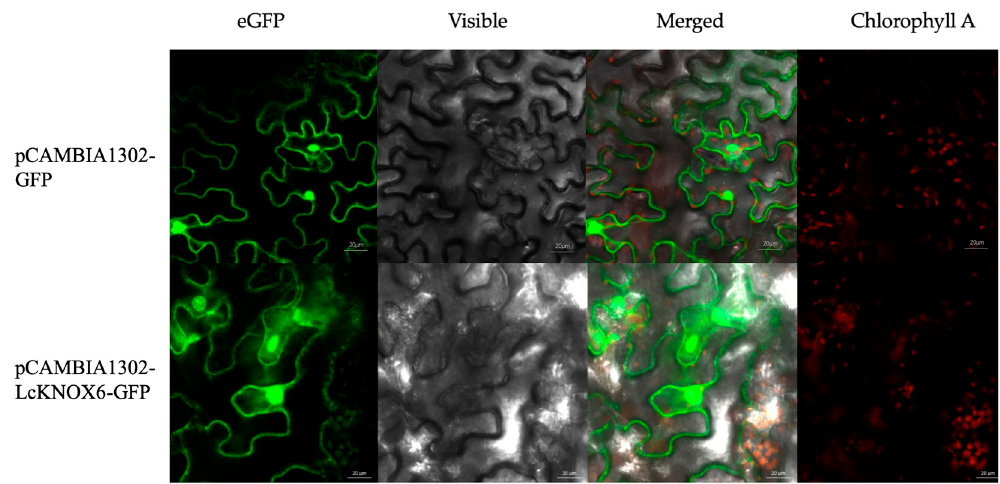
Figure 4. 35S::LcKNOX6 subcellular localization in Nicotiana benthamiana leaves. The Expression of Genes Related to KNOX in Transgenic A. thaliana